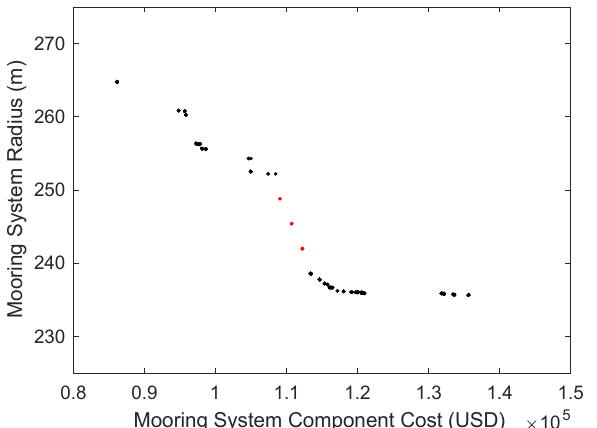
Figure 14. Designs along the Pareto-Optimal Front (black) with Interpolated Designs with Constraint Violations (red).